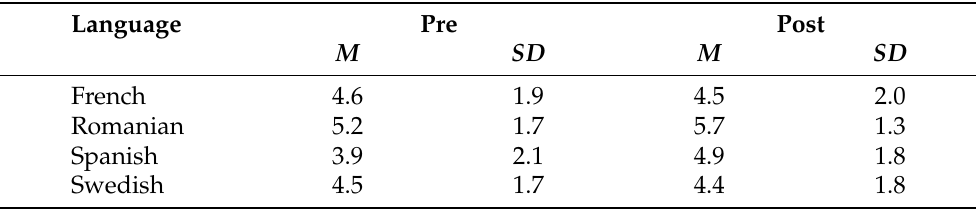
Table A5. I search for the source of the information.